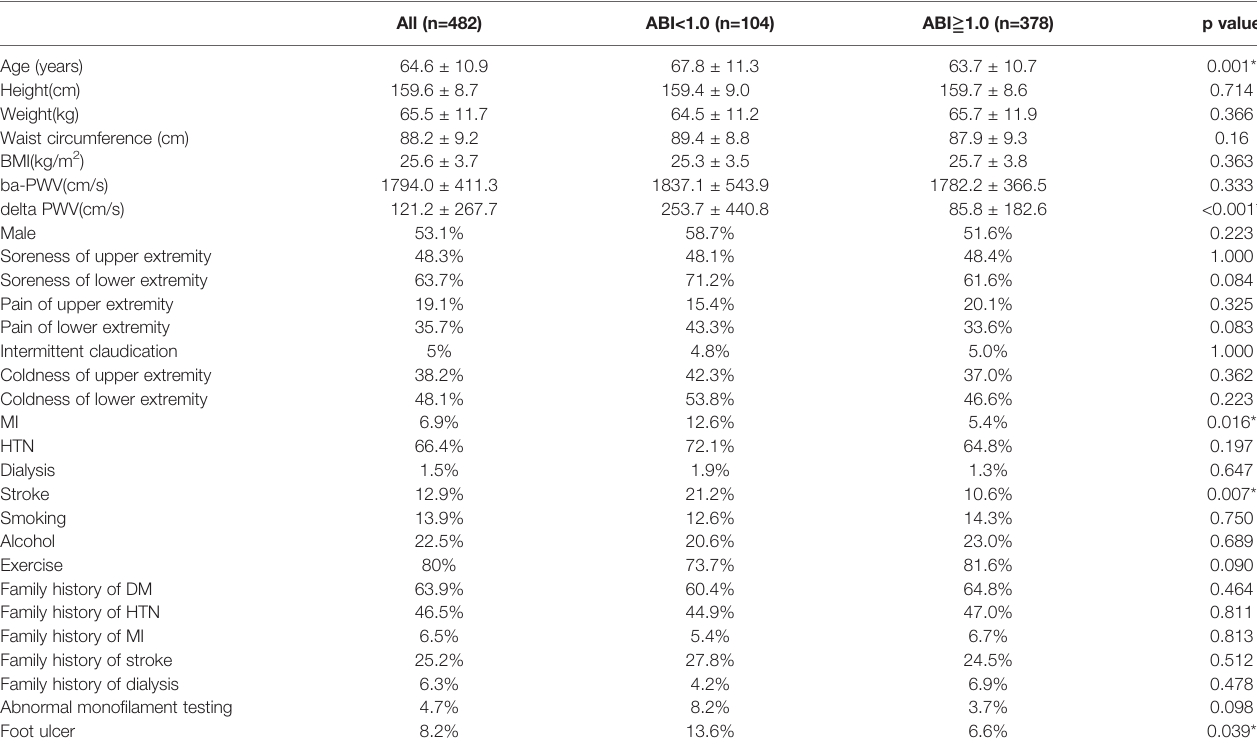
TABLE 1 | Variables in patients with low ABI (<1) versus patients with normal ABI ( ≧ 1).